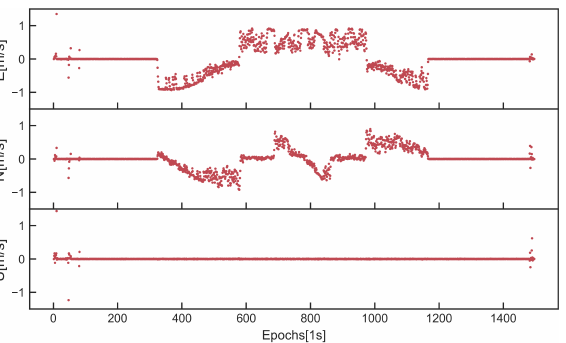
Figure 11. The velocity of remote − control kart for kinematic experiments.